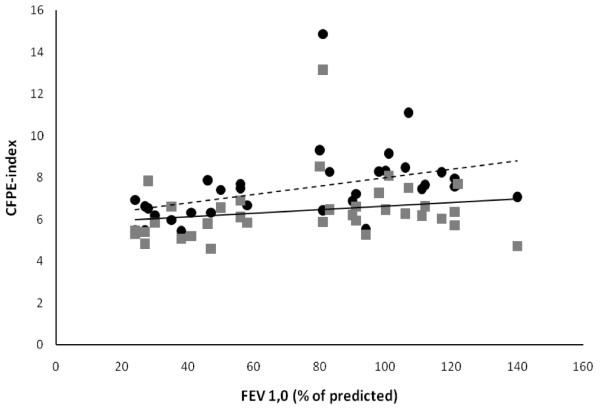
Relationship between degree of airflow obstruction expressed as percent of predicted FEV1.0 and CFPE-index for type I and type IIa fibres; "black circle" = type I fibres (--- = regression line for type CFPE-index for type I fibres, r = 0.61, p < 0.001), "grey square"= type IIa fibres (-- = regression line for CFPE-index for type IIa fibres, r = 0.37, p = 0.04); FEV1,0 = forced expiratory volume in one second; CFPE-index = quotient between individual capillary-to-fibre ratio and fibre perimeter.